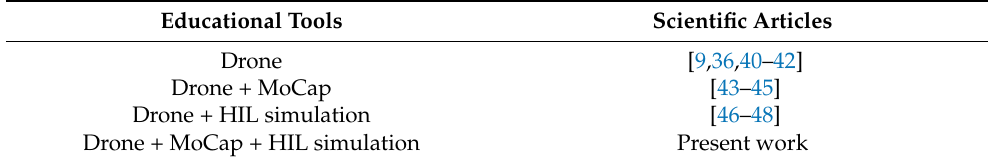
Table 1. Comparison between related works using educational tools: drone, MoCap, and HIL